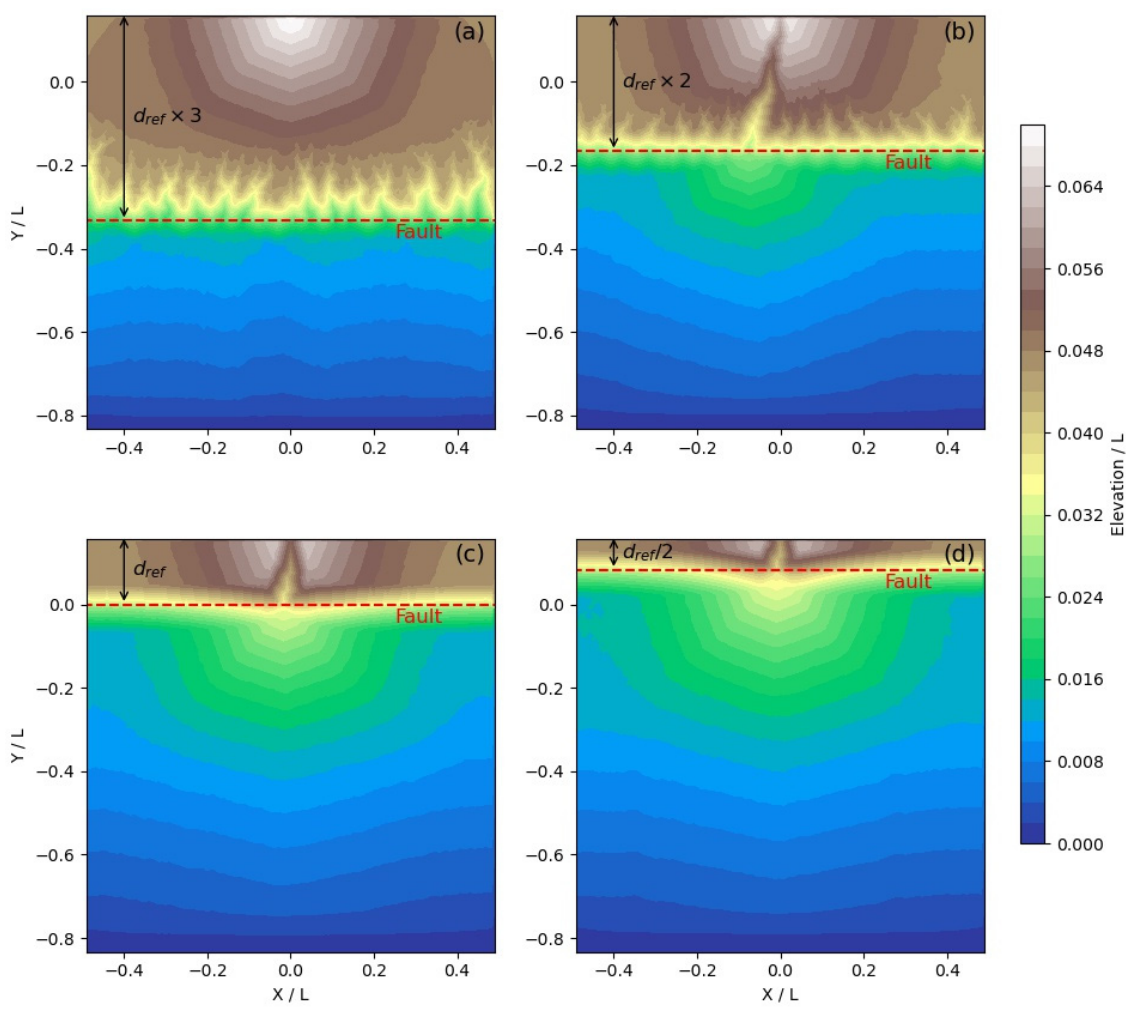
Figure 14. Role of fault location on alluvial fan morphology using a fault slip rate of 3 × v ref . Color scale gives the normalized elevation. The red dashed line indicates the fault trace location. d ref = L /6 is the distance in the reference model between the top edge of the model and the fault trace. The effect of this distance is tested for ( a ) d ref × 3, ( b ) d ref × 2, ( c ) d ref and ( d ) d ref /2 .